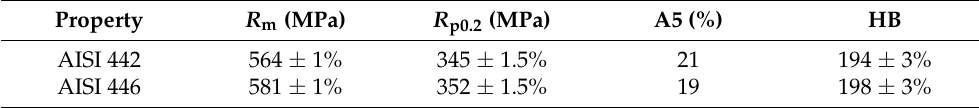
Table 5. Mechanical properties of AISI 442 and AISI